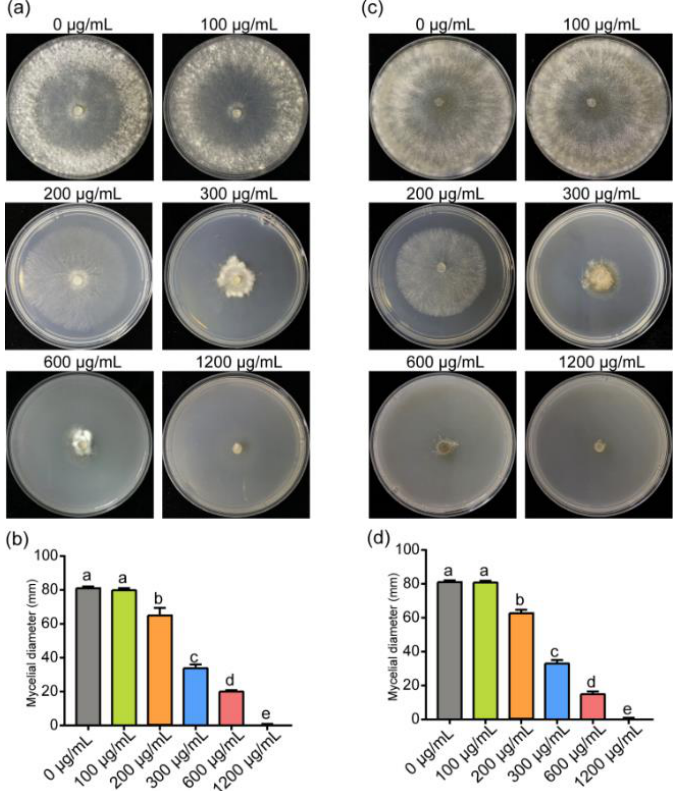
Figure 1. Effects of different concentrations of ε -PL on the mycelial growth of Sclerotinia sclerotiorum and Botrytis cinerea . ( a ) Colonies of S. sclerotiorum treated with ε -PL at concentrations of 0, 100, 200, 300, 600 and 1200 µ g/mL at 3 dpi. ( b ) Mycelial growth of S. sclerotiorum affected by different concentrations of ε -PL. ( c ) Colonies of B . cinerea treated with ε -PL at concentrations of 0, 100, 200, 300, 600 and 1200 µ g/mL at 4 dpi. ( d ) Mycelial growth of B. cinerea affected by different concentrations of ε -PL. Different letters indicate significant differences ( p < 0.05).